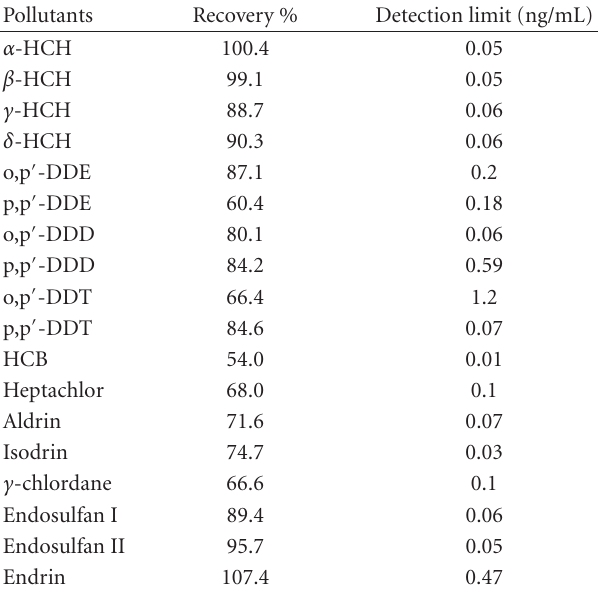
Table 1: The method recoveries and the instrument detection